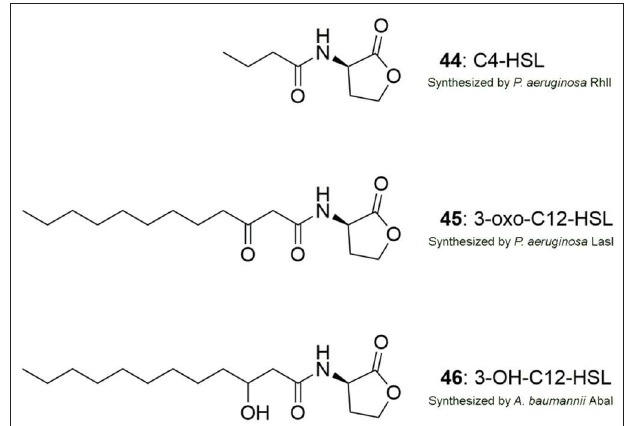
FIGURE 12 | Structures of the AHL signal molecules produced by P. aeruginosa ( 44 , 45 ) and A. baumannii ( 46 ).